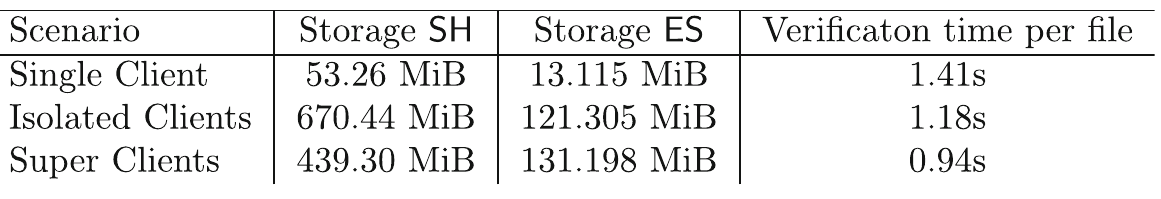
Fig. 3 Evaluation of the three tested